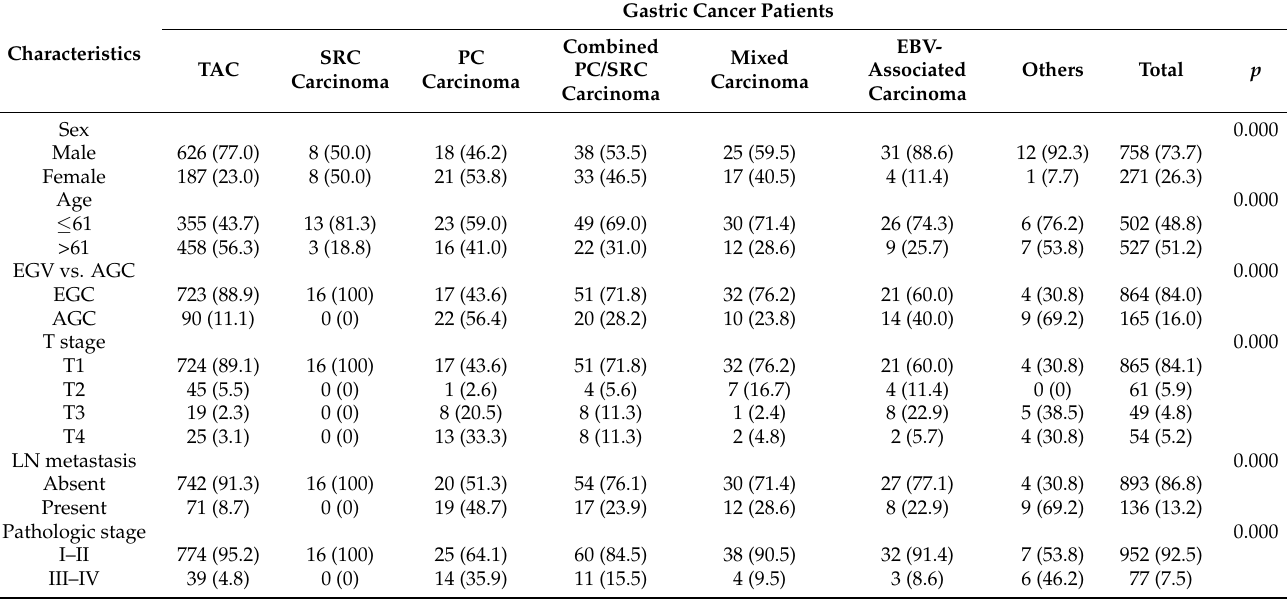
Table 1. Clinicopathologic characteristics of gastric cancer patients ( n = 1029).